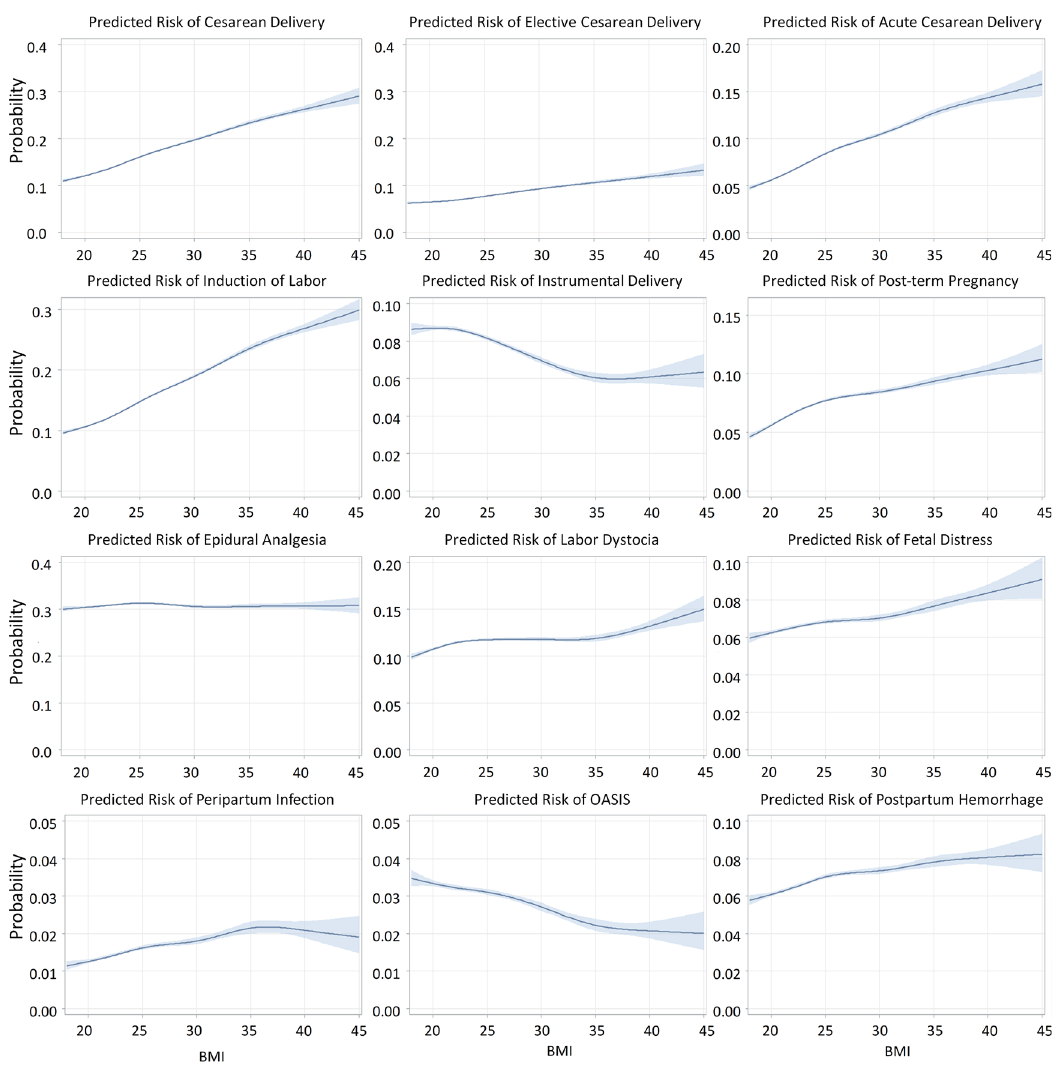
Fig 1. Relation between early-pregnancy BMI and delivery outcomes ( N = 729,867 (cid:3) singleton live births at or after 37 gestational weeks). X axis is BMI (kg/m 2 ); different Y axis scales. OASIS = obstetric anal sphincter injury (perineal tear grade III– IV). Acute (emergency) cesarean delivery = all unplanned cesarean sections. (cid:3) 798,338 minus 57,134 with missing BMI (excluding births to women with bariatric surgery history).